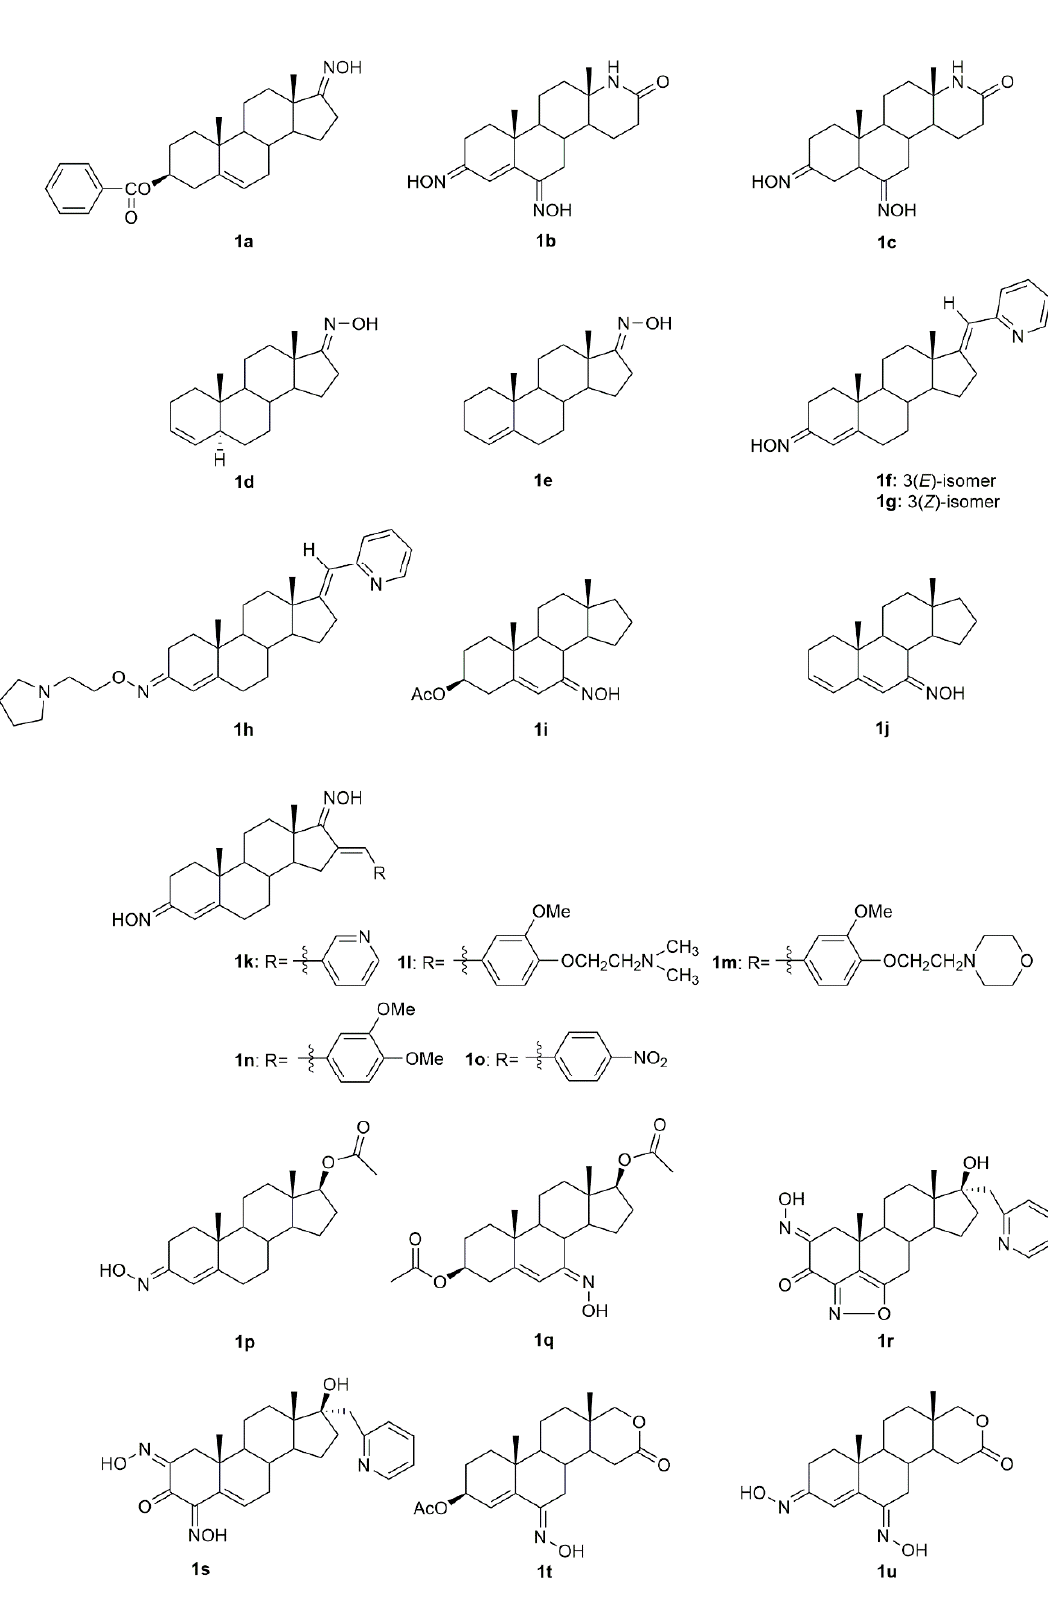
Figure 4. Androstane oxime derivatives with anticancer activity in several types of cancer cells. The introduction of a heteroatom or the substitution of one or more carbon atoms in the steroid scaffold by a heteroatom can have a great impact on the compound’s biological activity. Aza-homosteroids are a class of compounds with unusual structures, which